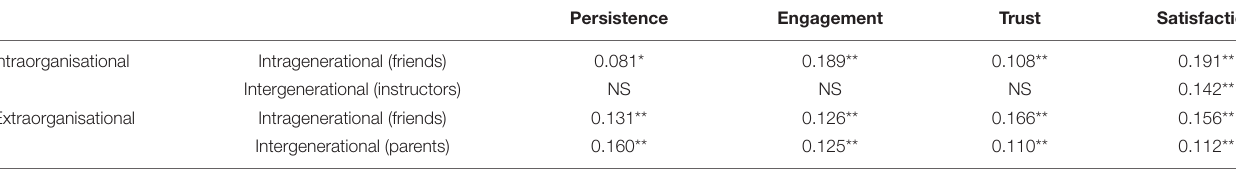
TABLE 1 | Correlation of changing students’ relationship with changing achievement predictors.